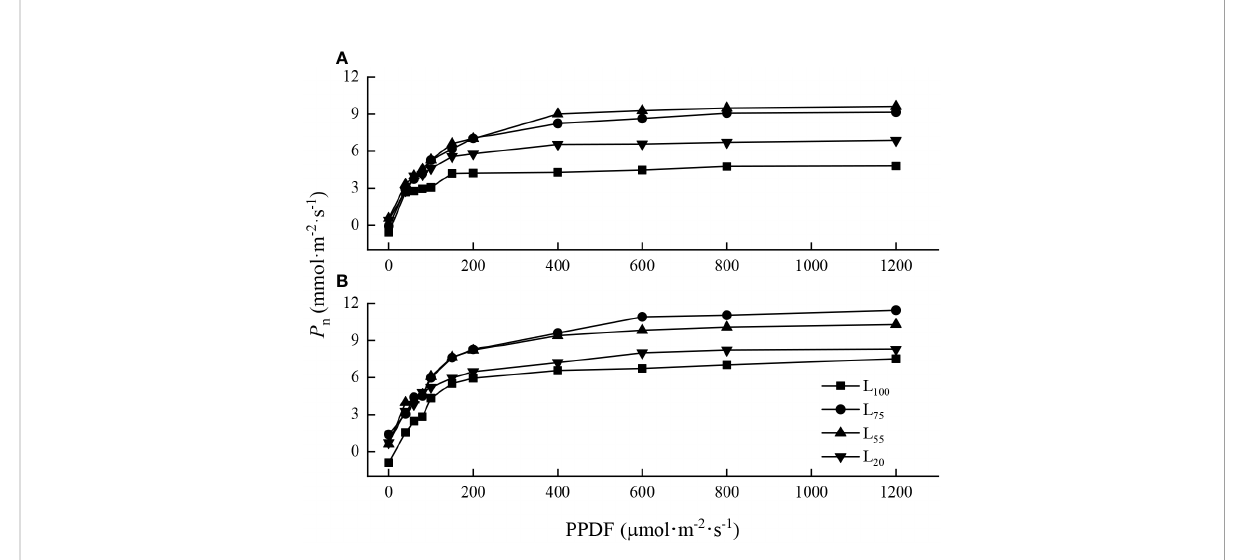
FIGURE 1 Light-photosynthetic response curves of two maple seedlings under different light intensities. (A) , A. pseudosieboldianum ; (B) , A. mono